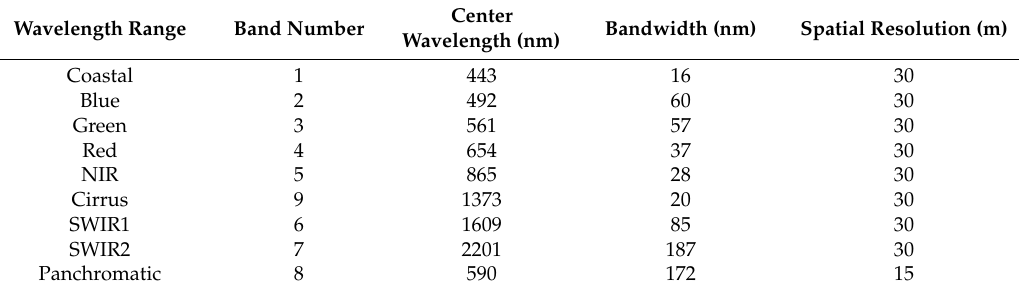
Table 1. Salient characteristics of Landsat-8 Operational Land Imager